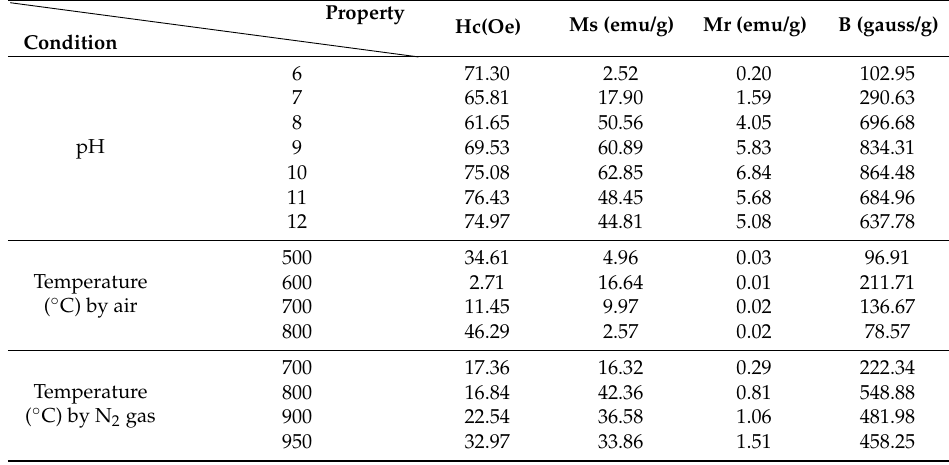
Figure 4. The effect of the pH value on the magnetic properties of [Mn 0.54 Zn 0.46 ]Fe 2 O 4 that is produced from waste dry batteries. Table 1. The effect of various factors on the magnetic properties of [Mn 0.54 Zn 0.46 ]Fe 2 O 4 that is produced from waste dry batteries.